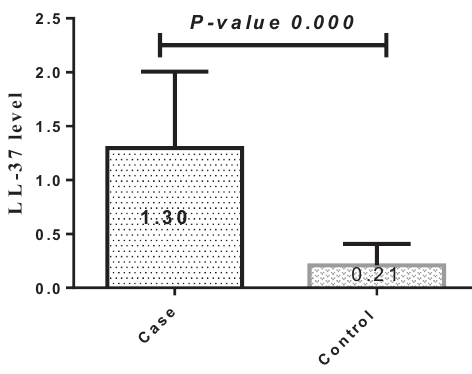
Figure 3: Mean of LL-37 across study groups.